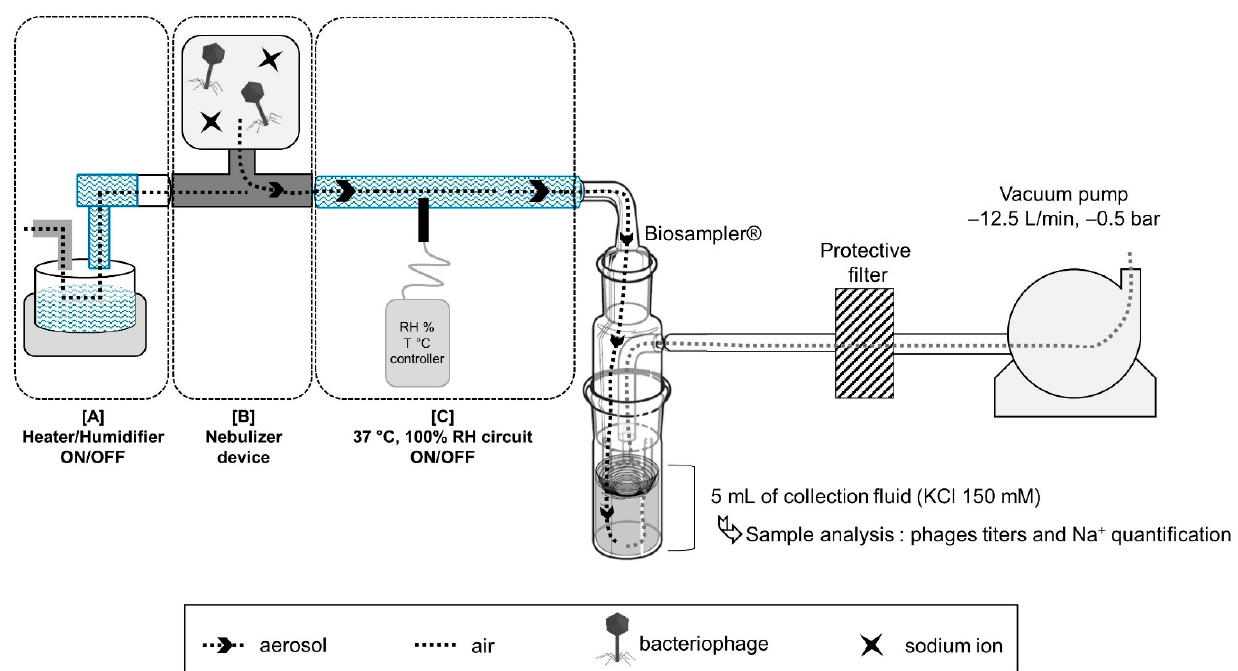
Figure 2. Bench study for in vitro assessment of parameters influencing phage viability: phage morphotypes and humidity. In the center of the figure, the BioSampler ® gently aspirates and collects the aerosol containing the bacteriophage and sodium ion from the top opening through a 5 mL vortex fluid of KCl (150 mM), by following − 0.5 bar depressurized air from a vacuum pump settled at − 12.5 L/min. Step one was to connect the nebulizer device alone [B] to the BioSampler ® to assess